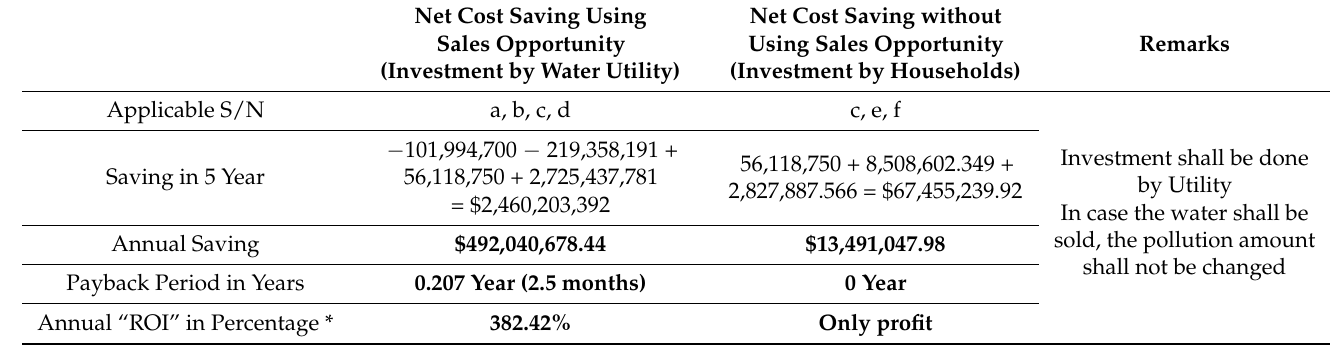
Table 6. Techno-economy analysis for “Indirect